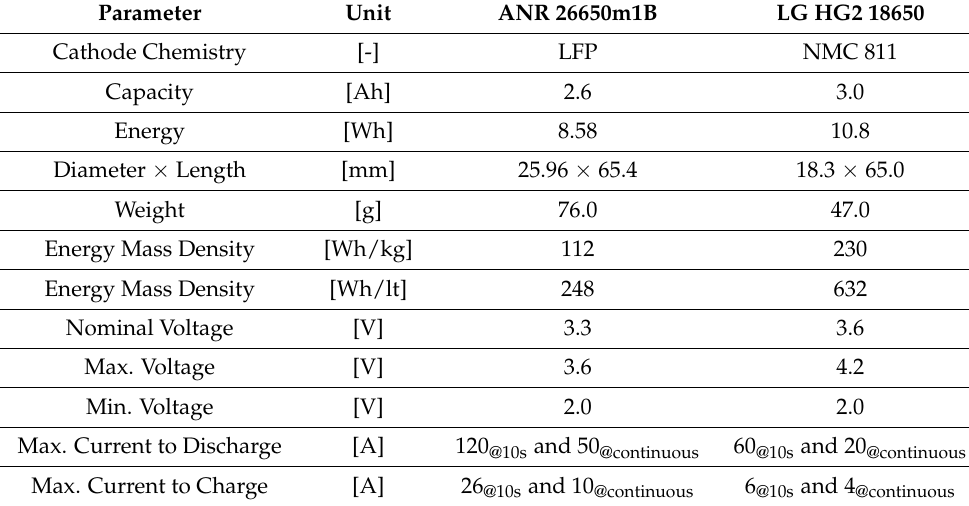
Table 3. Lithium-ion cell main characteristics for the LFP and NMC